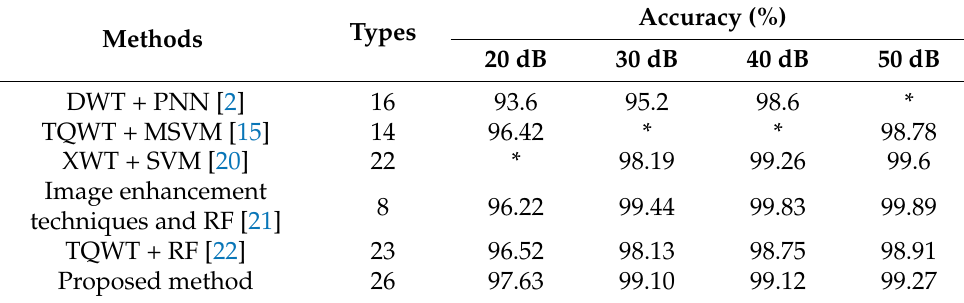
Table 4. Performance comparison of proposed method with other existing methods.